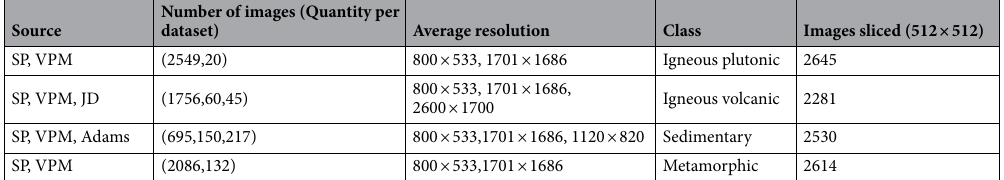
Table 4. Data precedence for thin sections used for training, SP: Strekeisen Project, VPM: Virtual Microscope Project, Adams: Atlas of sedimentary rocks [Adams et al., 1984], JD: J. M.